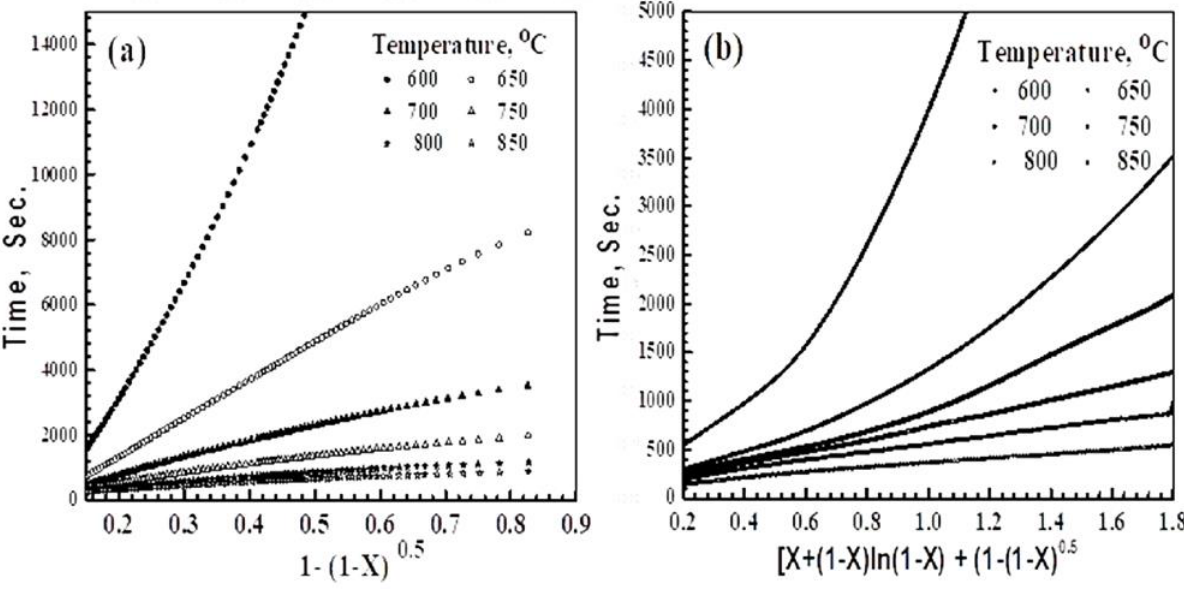
Figure 9. Application of mathematical equations for the reduction of precursors at 600–850 °C in H 2 : ( a ) precursor A; and ( b ) precursor B.